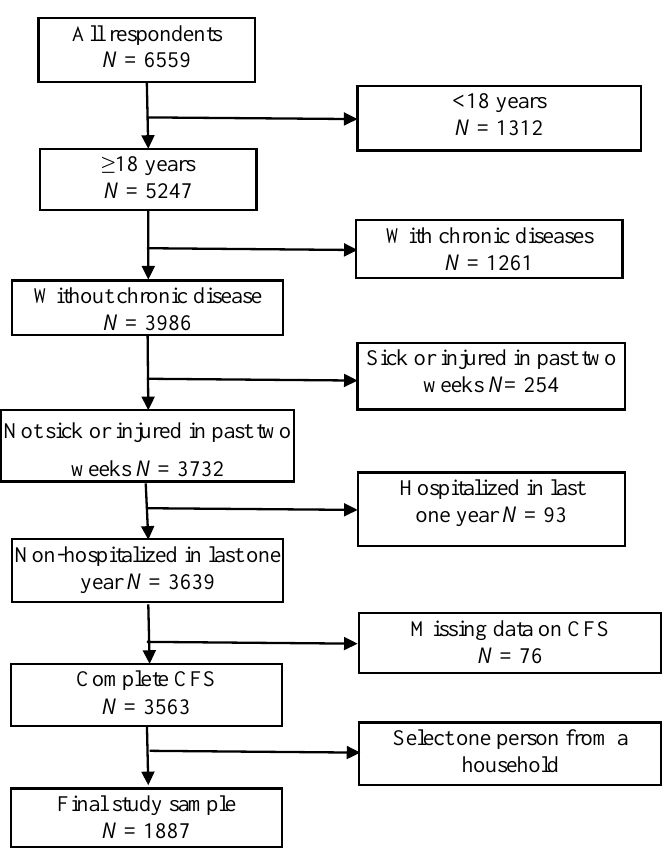
Figure 1. Flow chart in the selection of study subjects.